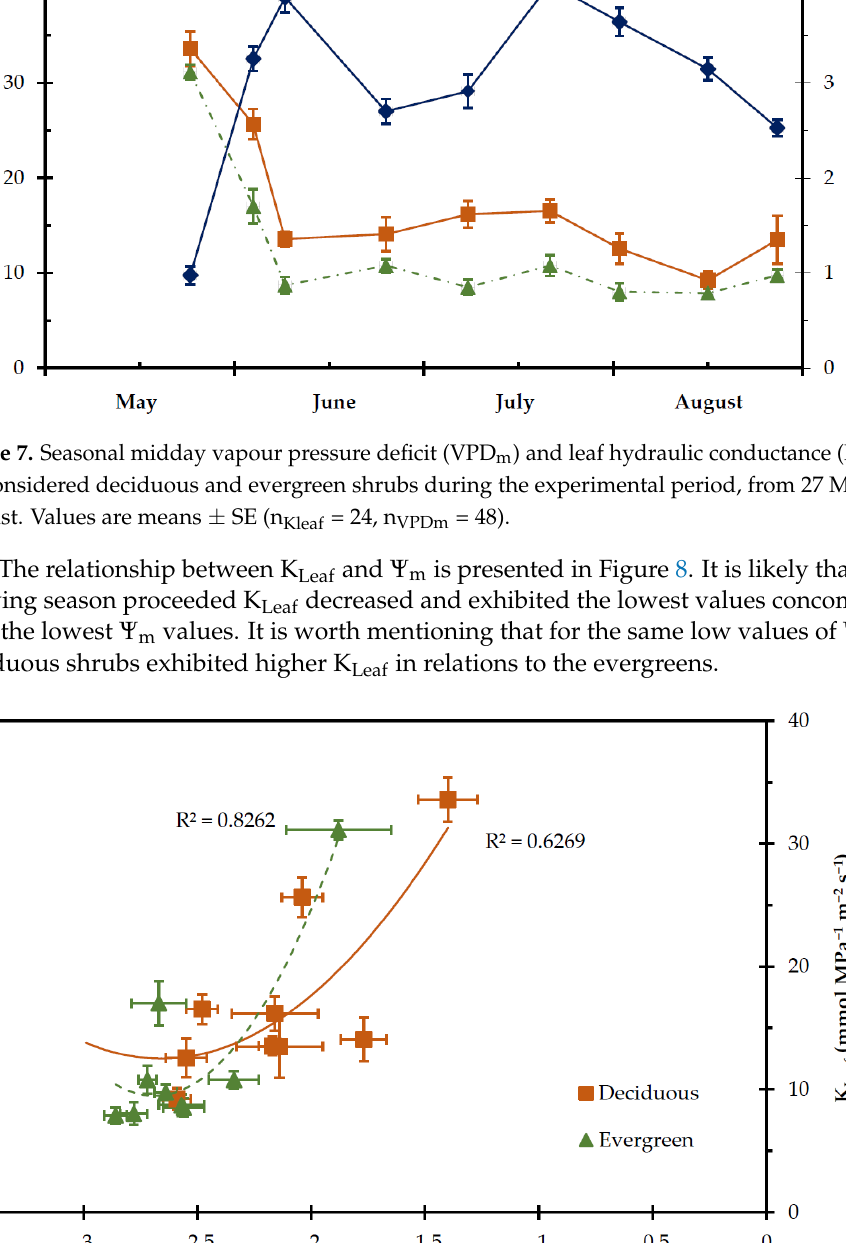
Table 2. Pearson correlation between predawn (Ψ p ) and midday leaf water potential (Ψ m ), transpi- ration rate (E), stomatal conductance (g s ), leaf hydraulic conductance (K Leaf ) and midday Vapour Pressure Deficit (VPD m ) for deciduous (left) and evergreen (right) shrubs.